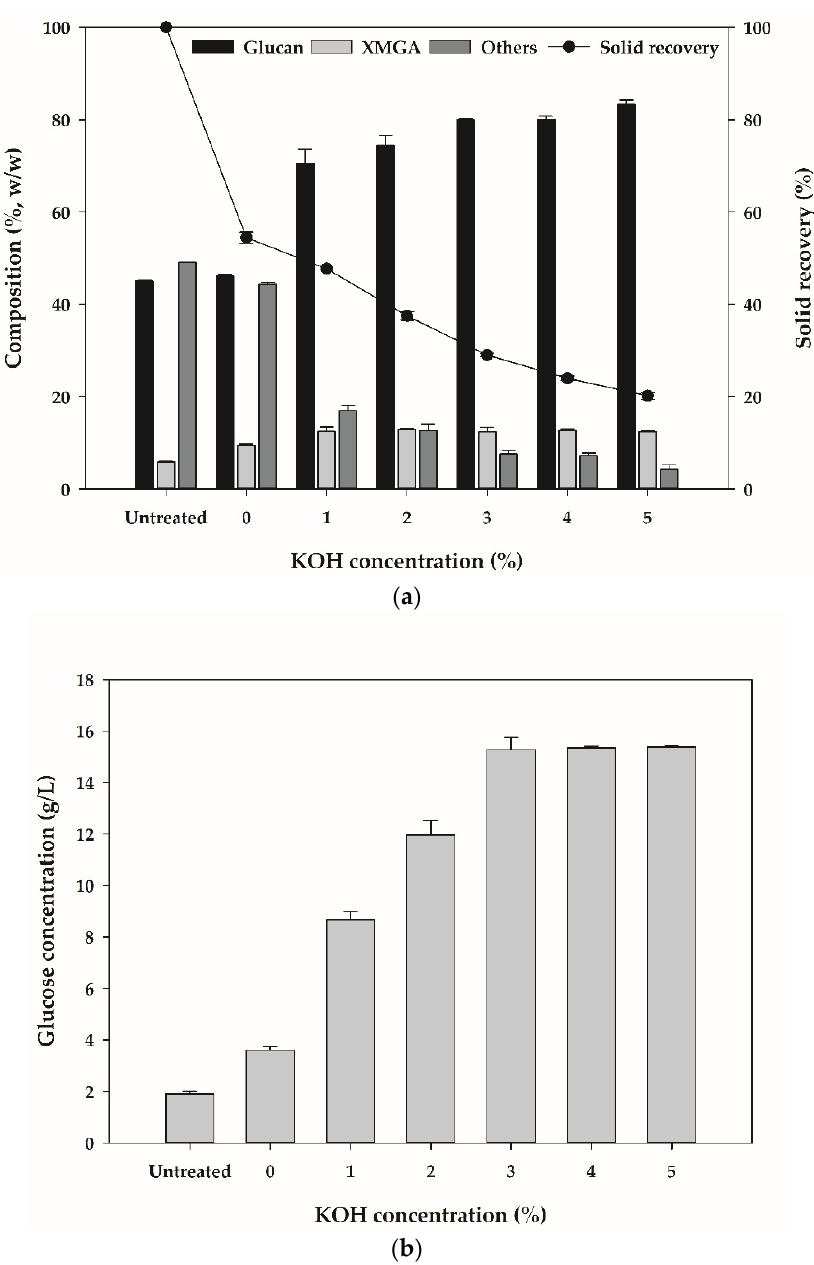
Figure 1. Effect of KOH pretreatment of chestnut shells (CNSs) on chemical composition ( a ) and the released glucose concentrations after the enzymatic hydrolysis ( b ).